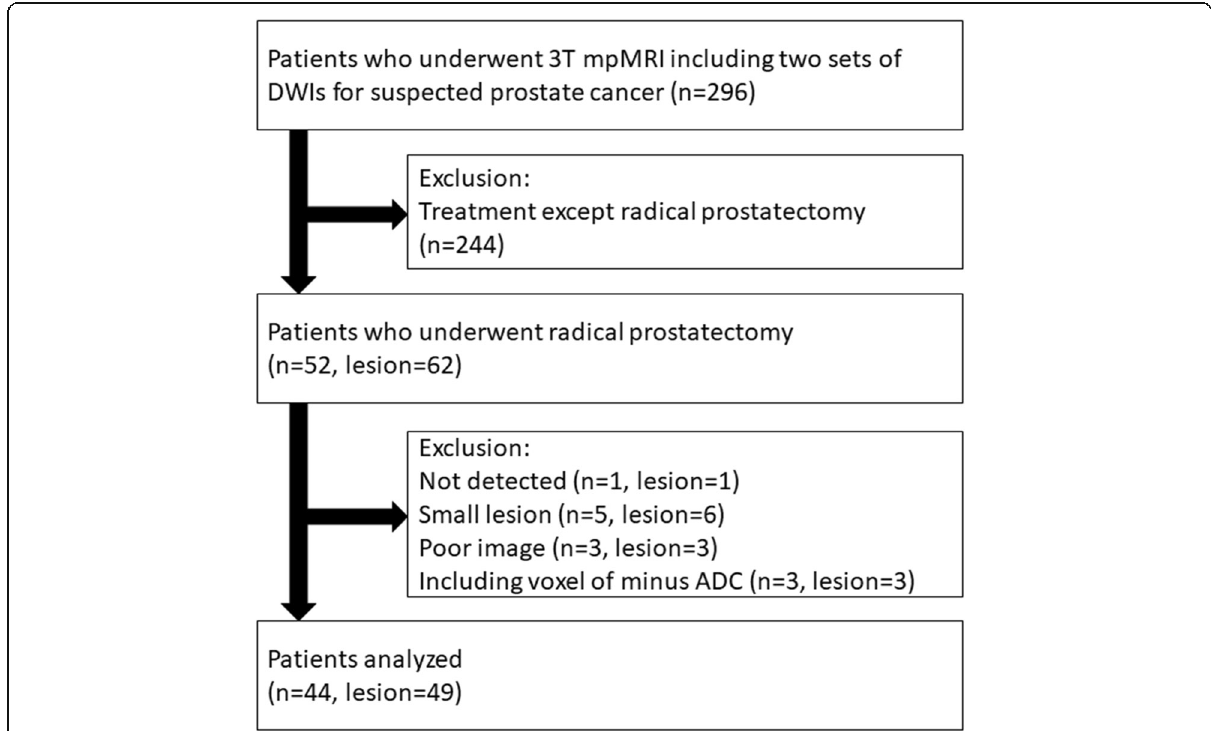
Fig. 1 Flowchart of study showing inclusion and exclusion criteria, and patient and lesion